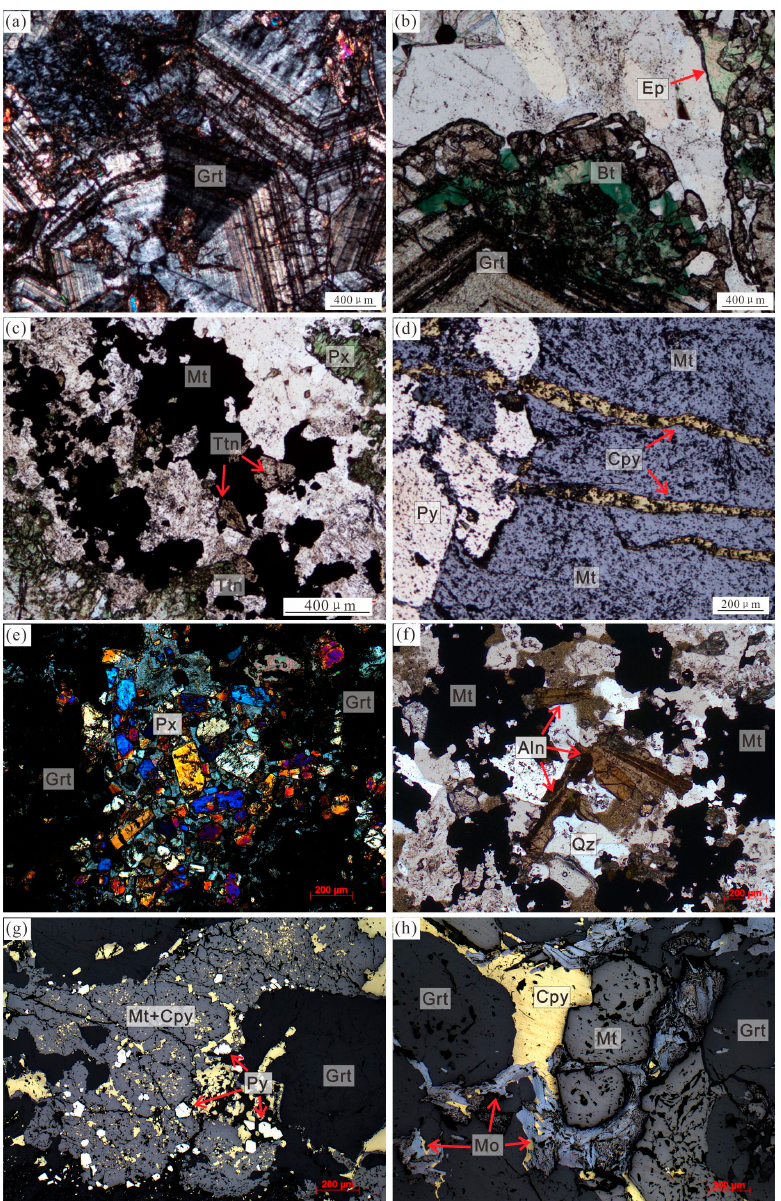
Figure 4. Photomicrographs of samples from different ore forming stages in: the Beiya deposit ( a – d ); and the Machangqing deposit ( e – h ) (( a , e ) prograde skarn (garnet + pyroxene) mineral assemblage (cross-polarized light); ( b , c , f ) retrograde alteration (allanite + titanite + magnetite + biotite + quartz) mineral assemblage (plane-polarized light); and ( d , g – h ) quartz-sulfide mineralization (pyrite + chalcopyrite + magnetite + molybdenite) mineral assemblage (reflected light)). Abbreviations: Aln, allanite; Bt, biotite; Cpy, chalcopyrite; Ep, epidote; Grt, garnet; Mo, molybdenite; Mt, magnetite; Px, pyroxene; Py, pyrite; Qz, quartz; Ttn, titanite.